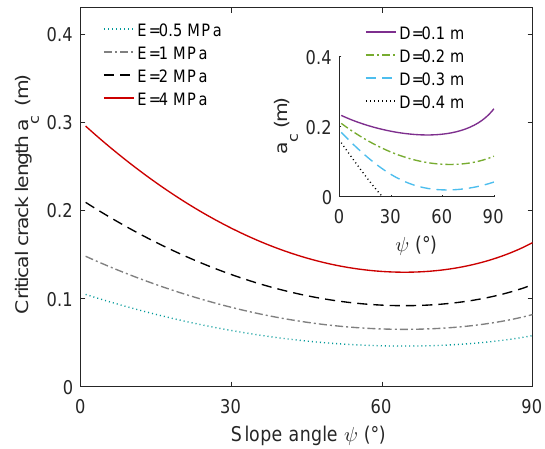
Figure 7. Effect of the slab elastic modulus on the slope angle de- pendency of the critical crack length (Eq. 9) for ρ = 200kgm − 3 , D = 0 . 2m, D wl = 4cm. Inset: effect of slab thickness on the slope angle dependency of the critical crack length for ρ = 200kgm − 3 , E = 2MPa, D wl =